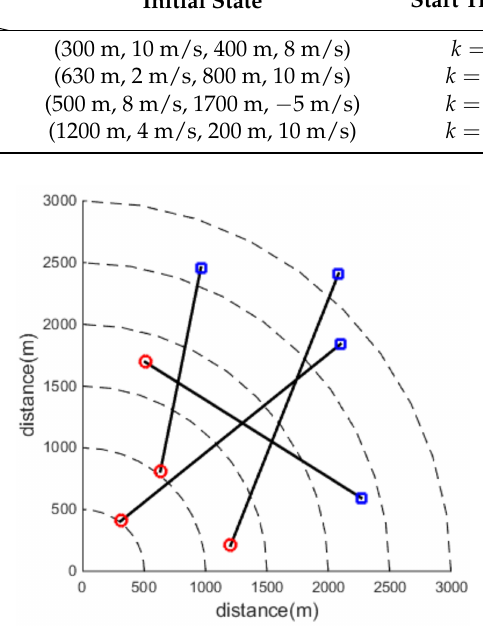
Figure 5. Trajectory of four target in two dimensional